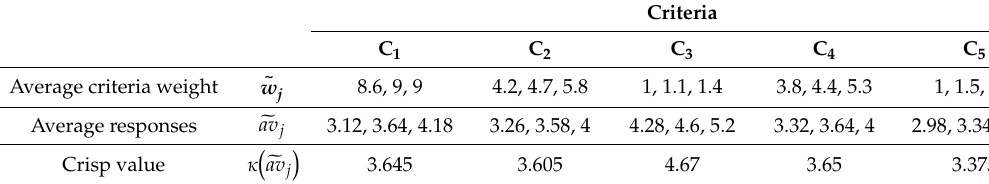
Table 8. Criteria weight.